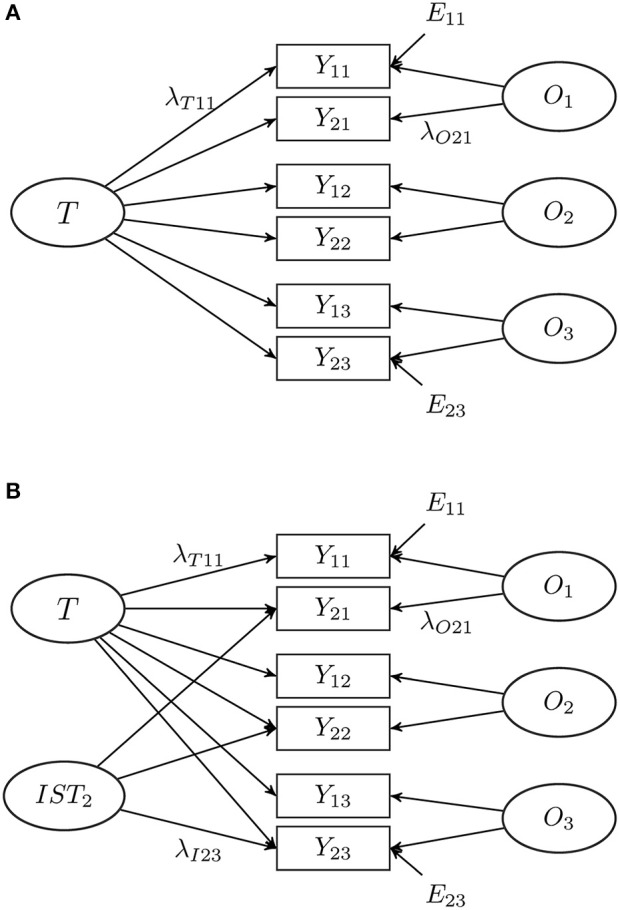
Examples of latent state-trait (LST) models with two indicators (i = 1, 2) and three occasions of measurement (j = 1, 2, 3). (A) Single-trait LST model; (B) LST model with an indicator-specific residual trait factor. Eij = error variables; IST2 = latent indicator-specific trait residual variable for the second indicator; Oj = latent occasion-specific variable; T = latent trait variable; Yij = observed variable; λTij, λOij and λIij = loading parameters.